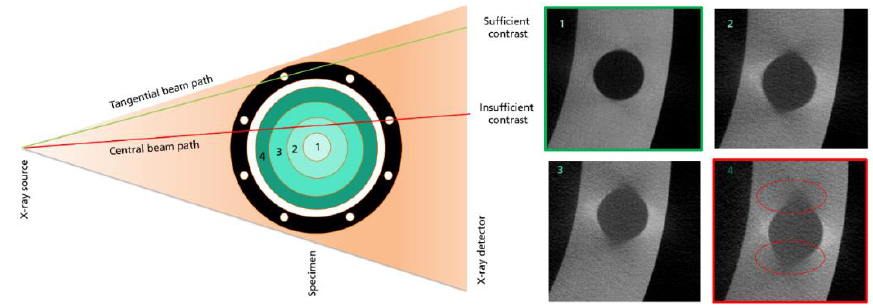
Figure 3. The schematic principle of the contrast properties in different beam positions and at different thickness layers (1–4). With a larger crystal diameter, the detection of the round shaped hole is affected.